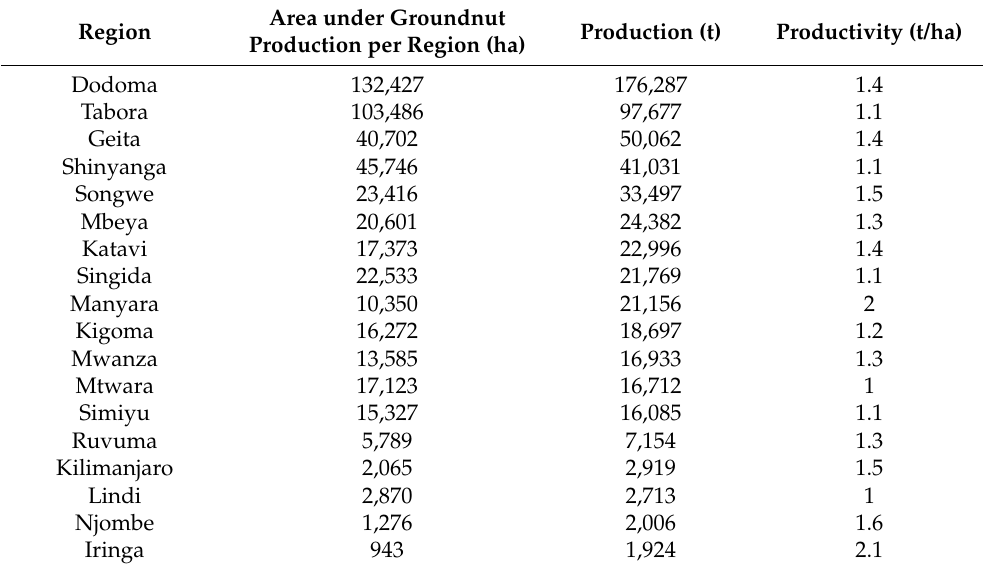
Table 1. Regions covered by the TL and AVISA projects (2008–2021), area allocated for groundnut production, and productivity per